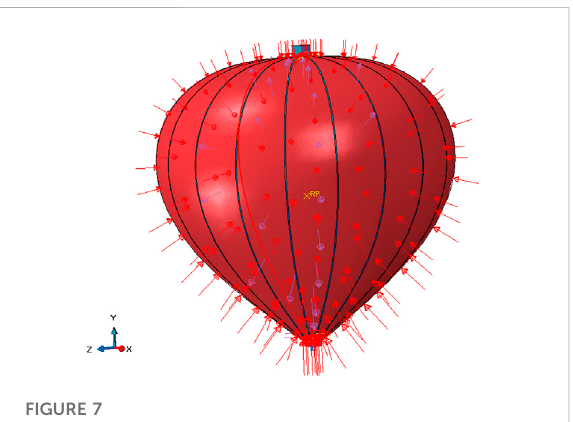
FIGURE 7 FEA model of the deformation – load